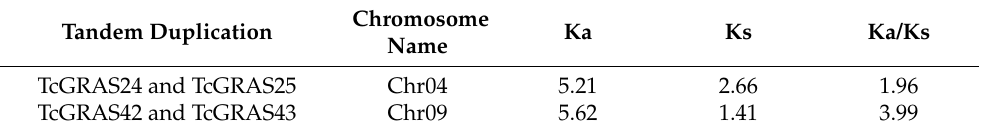
Table 3. Tandem duplication in TcGRAS genes and corresponding Ka, Ks, and Ka/Ks values.